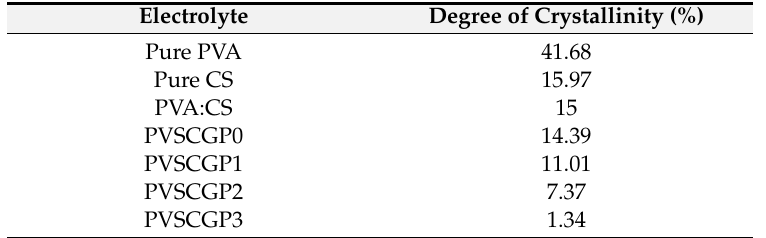
Table 1. The degree of crystallinity is calculated from the deconvoluted XRD pattern.